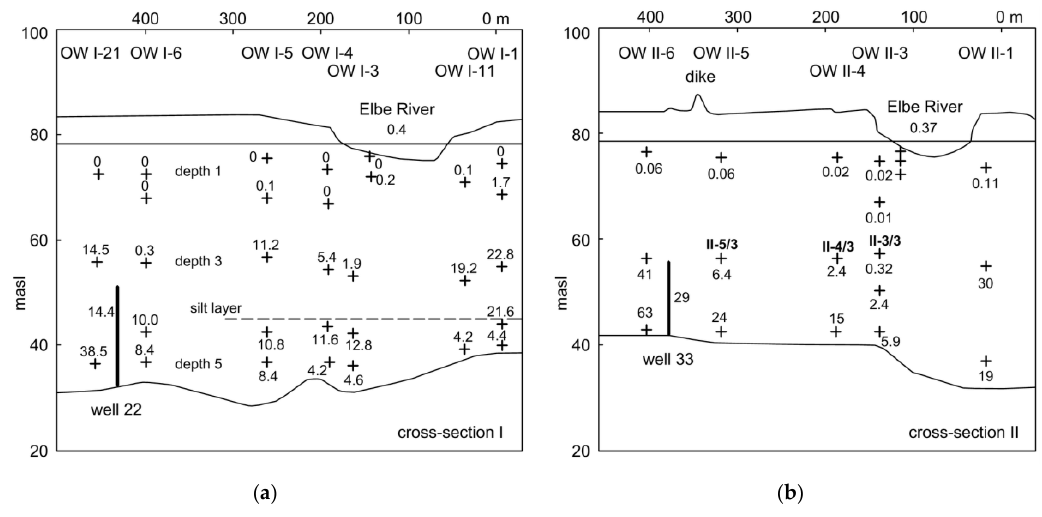
Table 1. Hydrochemical parameters of Elbe River water, bank filtrate (BF) near the river at OW I-4/2 and near the pumping well at OW I-6/3, pumped water from Well 22, and landside groundwater at OW I-21/3 at the RBF site in Torgau, Germany (median values for the period 1995-97, n > 36; location of OW see Figure 9).